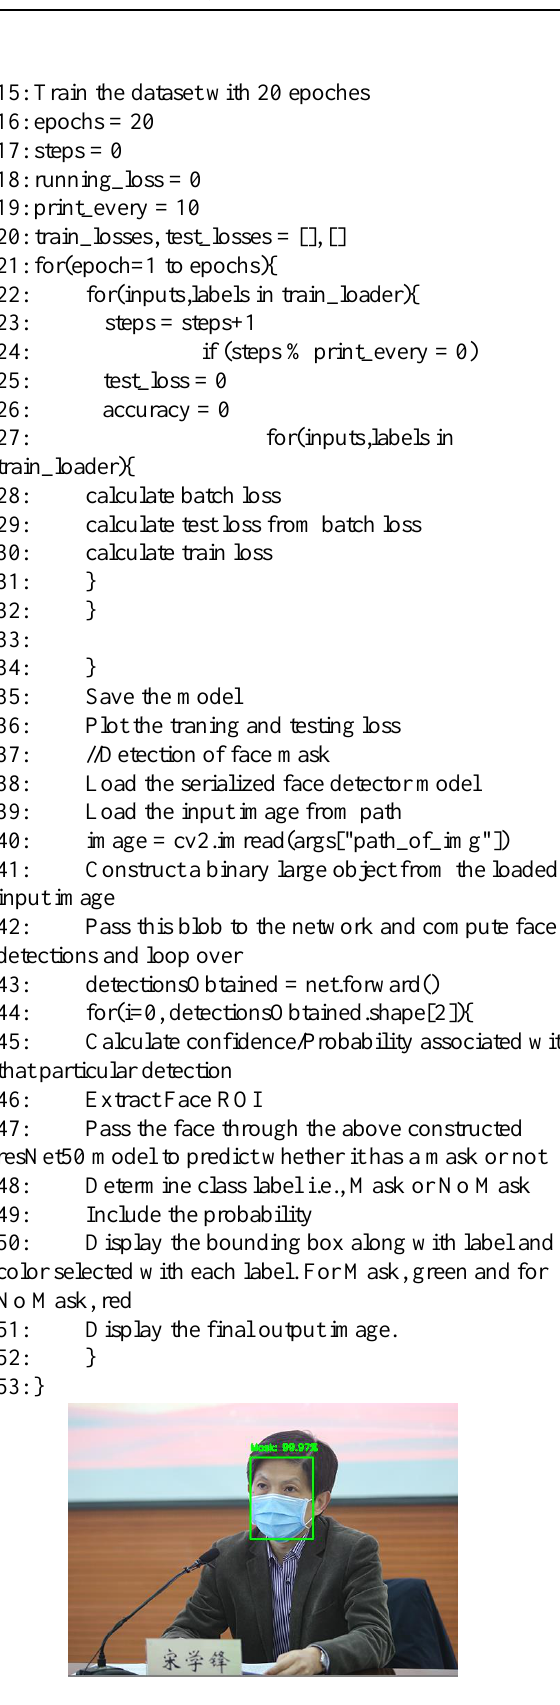
Figure 10. Detection of face mask with 99.97% probability